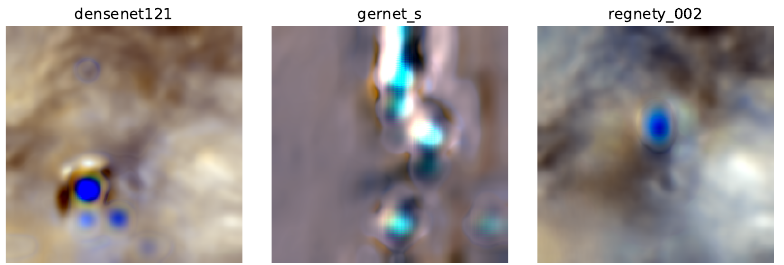
Figure 10. Examples of artifacts within the EVC output of three encoders that occasionally occur.